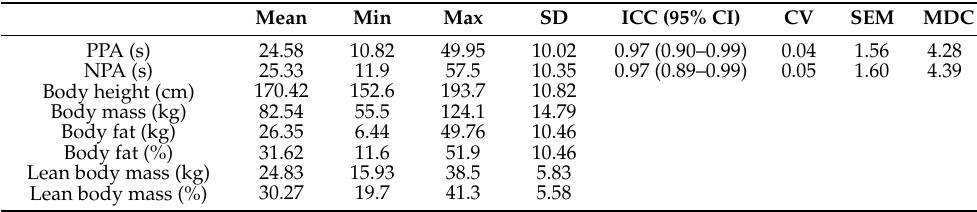
Table 2. Descriptive statistics for the measured variables and intra-testing reliability of the pre- planned and non-planned agility.